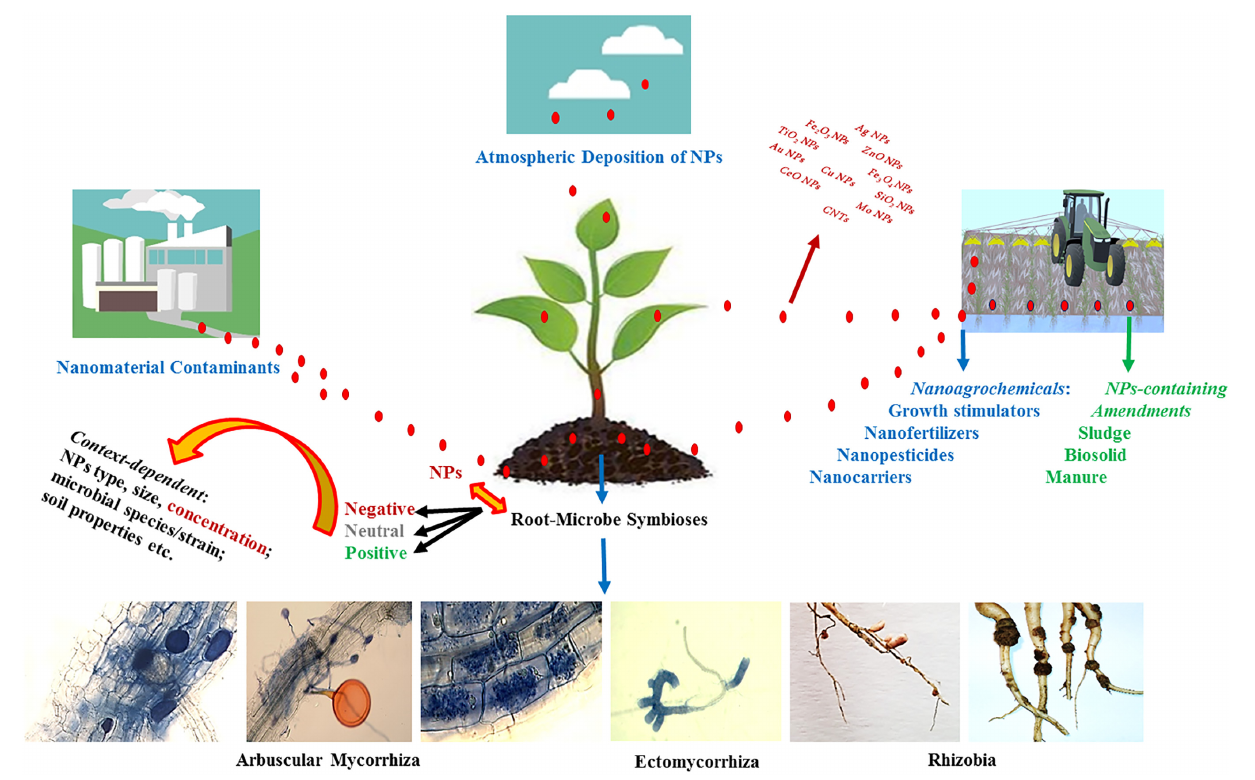
FIGURE 3 | A schematic diagram showing the routes by which mycorrhizas and rhizobia may encounter nanoparticles (NPs) in soil, and the possible context-dependent